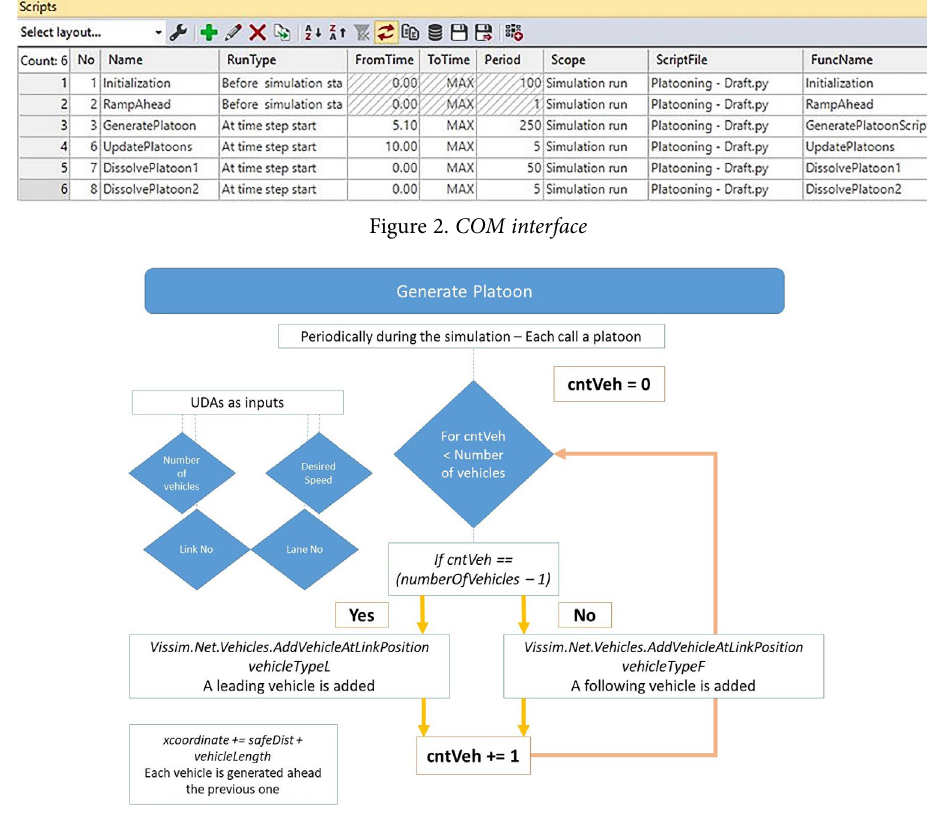
Figure 3. Generate Platoon